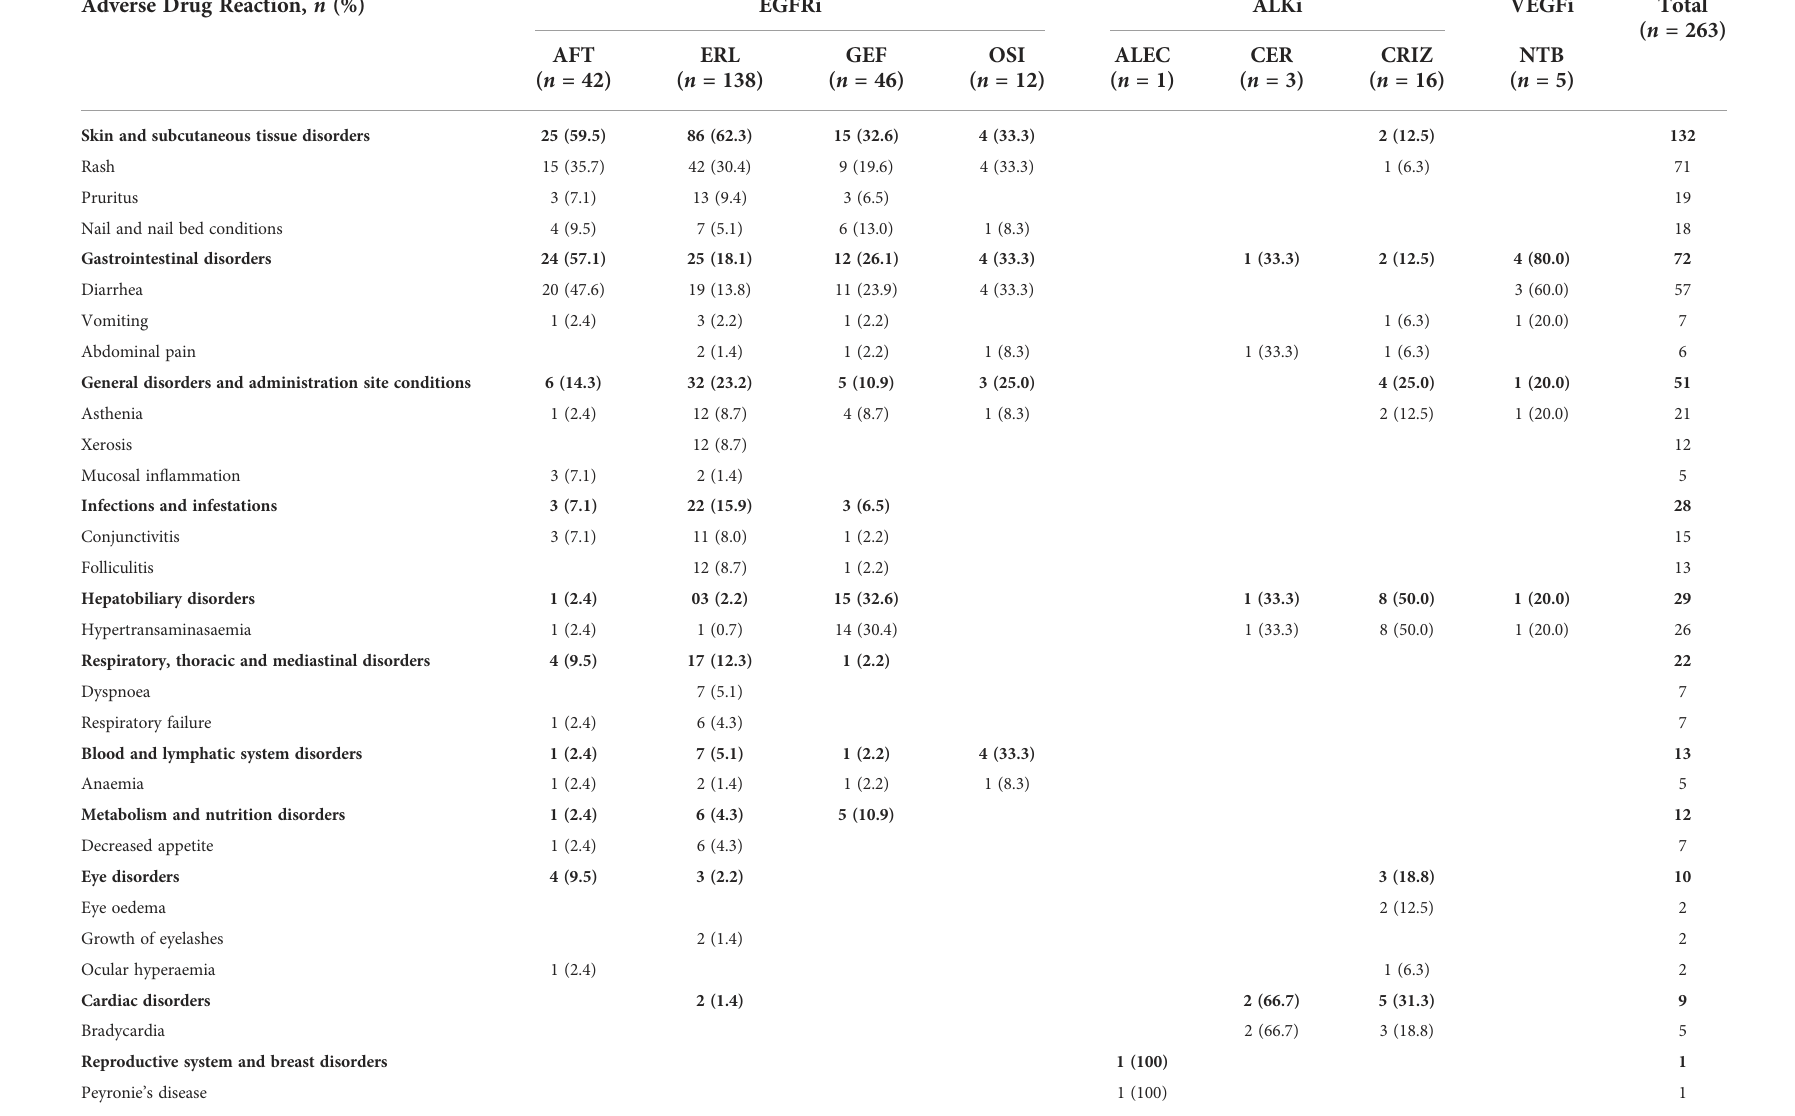
TABLE 4 Descriptions of main Sicilian ADRs associated with TKIs for NSCLC treatment and reported into the RNF. Adverse Drug Reaction, n